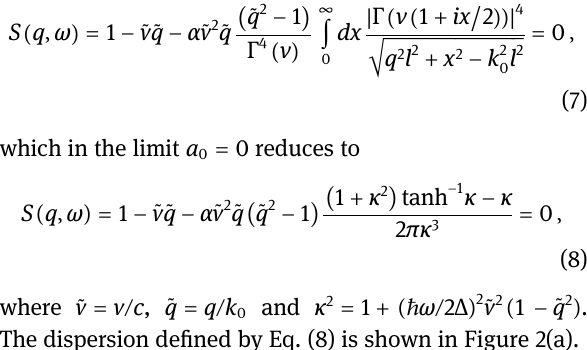
Figure 2: (a) Dispersion of the EPP for different values of ν : ν (cid:1) 0 . 1 (solid green), ν (cid:1) 0 . 5 (dotted red), and ν (cid:1) 1 (dashed blue). (b) The dimensionless parameter of the phase mismatch. The line legend is the same for fi gure (a). EPP, edge